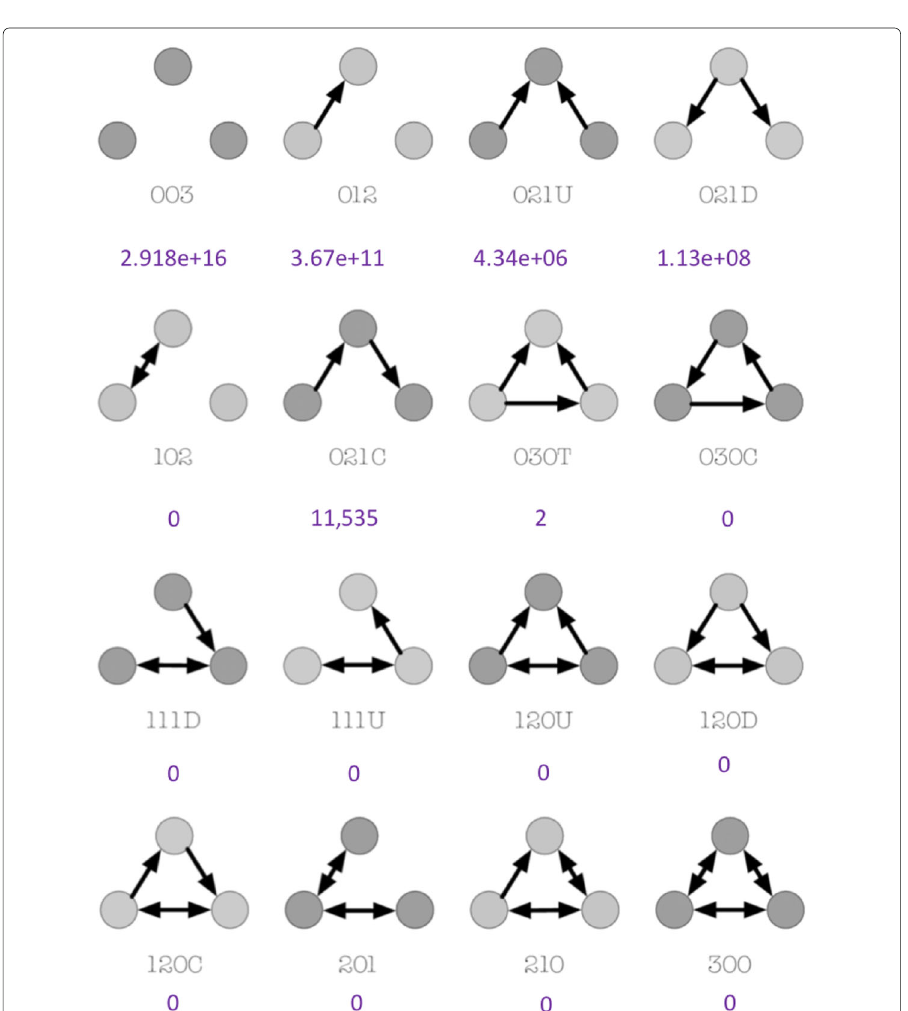
Fig. 3 A triad census of the simple network equivalent of the Panama multi-network